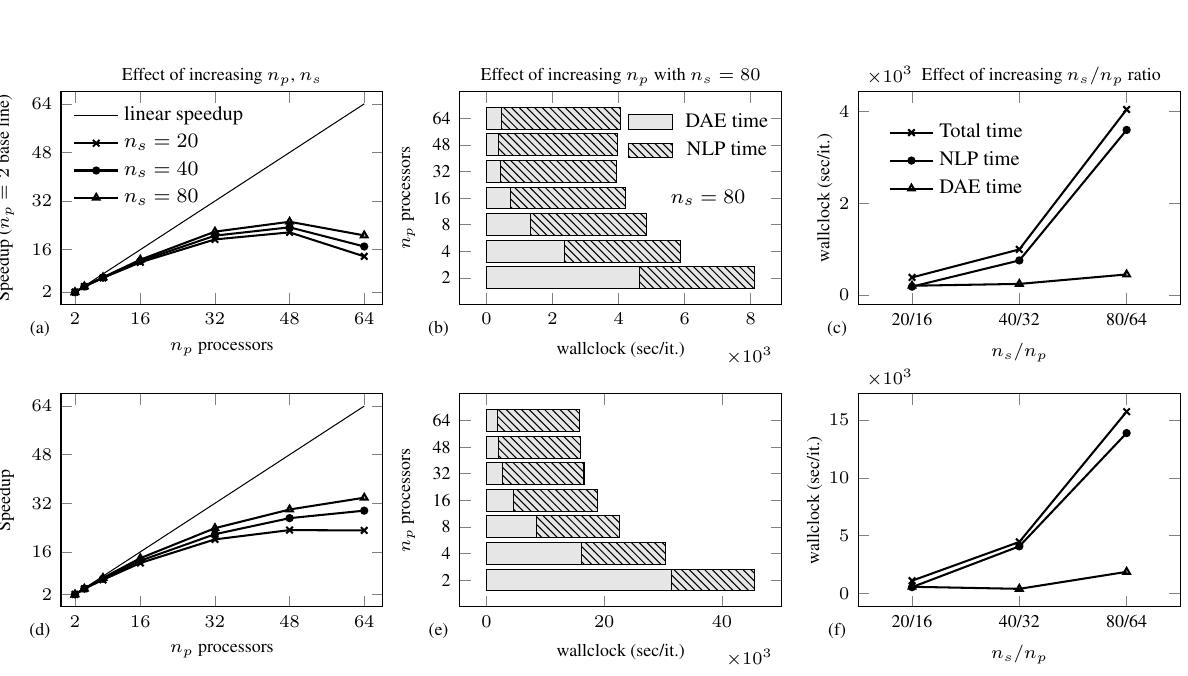
and n , where n = 6 p s